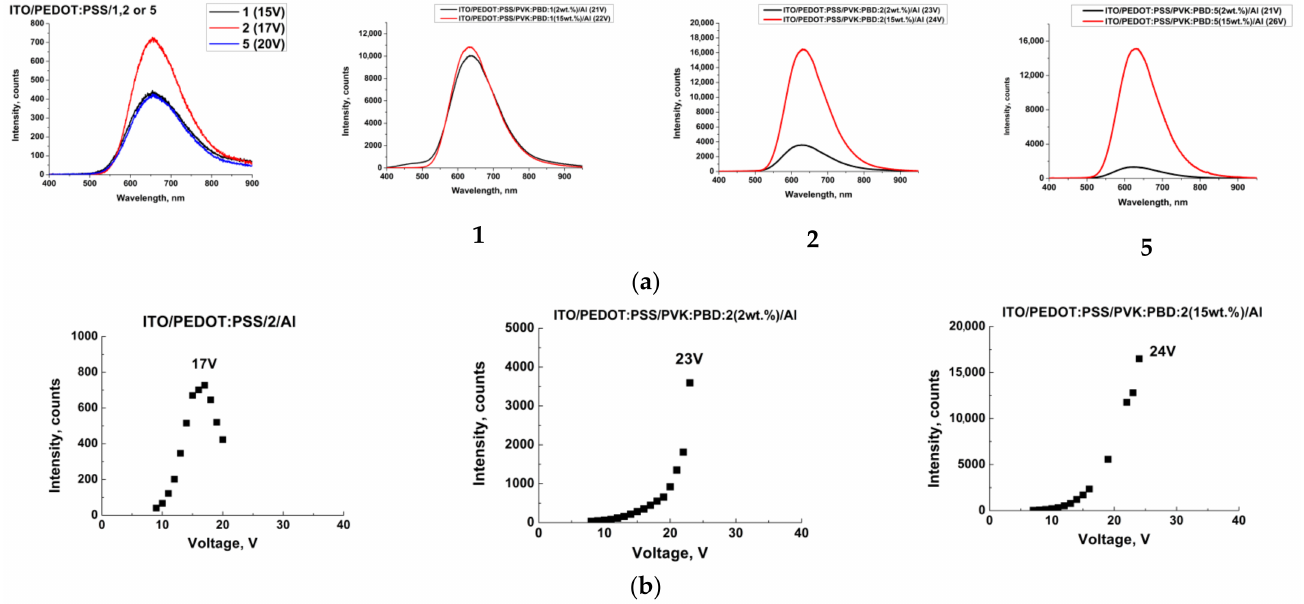
Figure 10. ( a ) EL spectra at maximum reached emission intensity of diodes based on complexes 1 , 2 and 5 and ( b ) example of applied voltage effect on EL